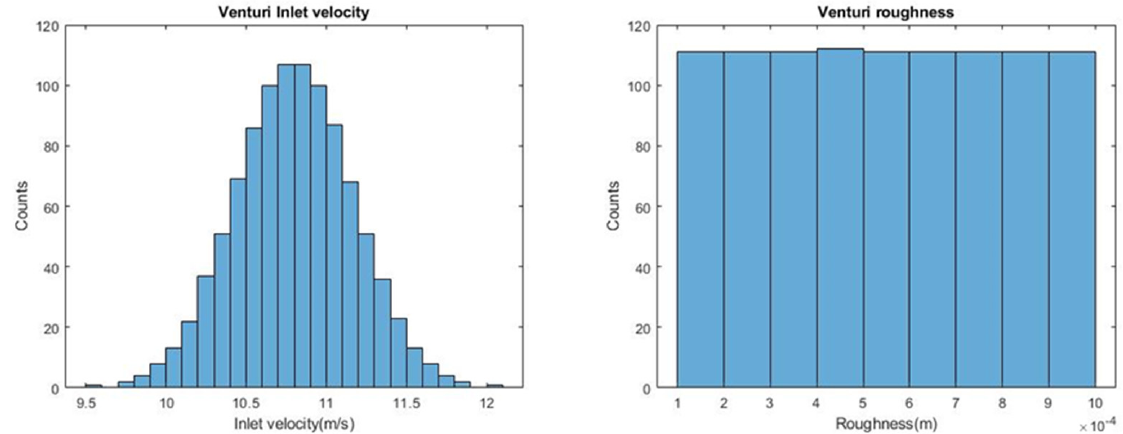
Figure 7. Histograms for the inputs of the random variables: inlet velocity and roughness.